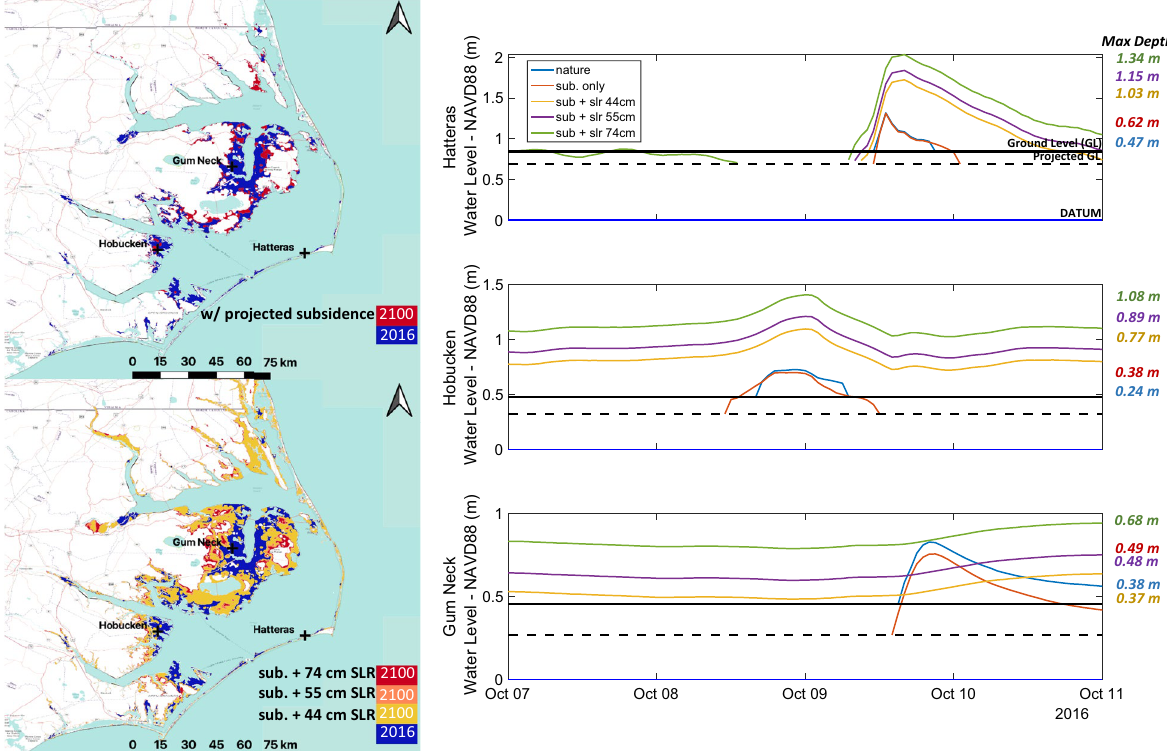
Figure 6. Hurricane Matthew flood extent and water level timeseries at indicated focus node locations including Gum Neck, Hobucken, and Hatteras, NC. Results summarized in Table 2. Figure created in QGIS (Version 3.16, https:// qgis. org/ en/ site/ forus ers/ downl oad. html) using ESRI Transportation and Terrain